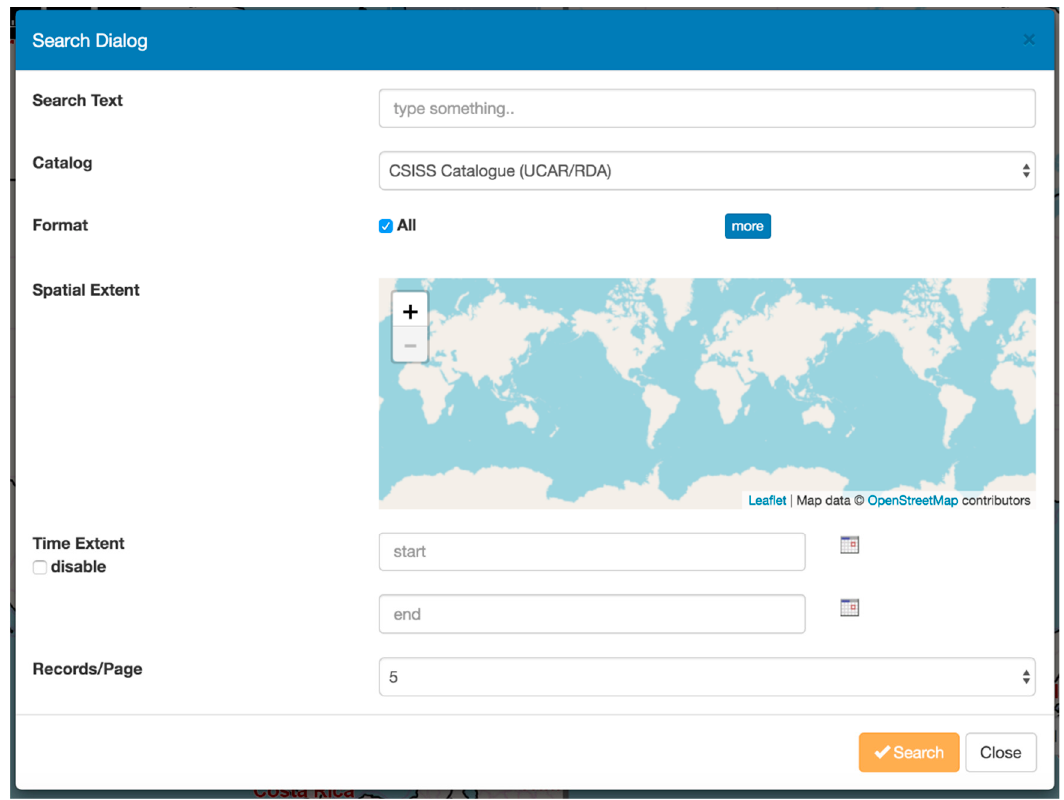
Figure 11. Search client web interface.